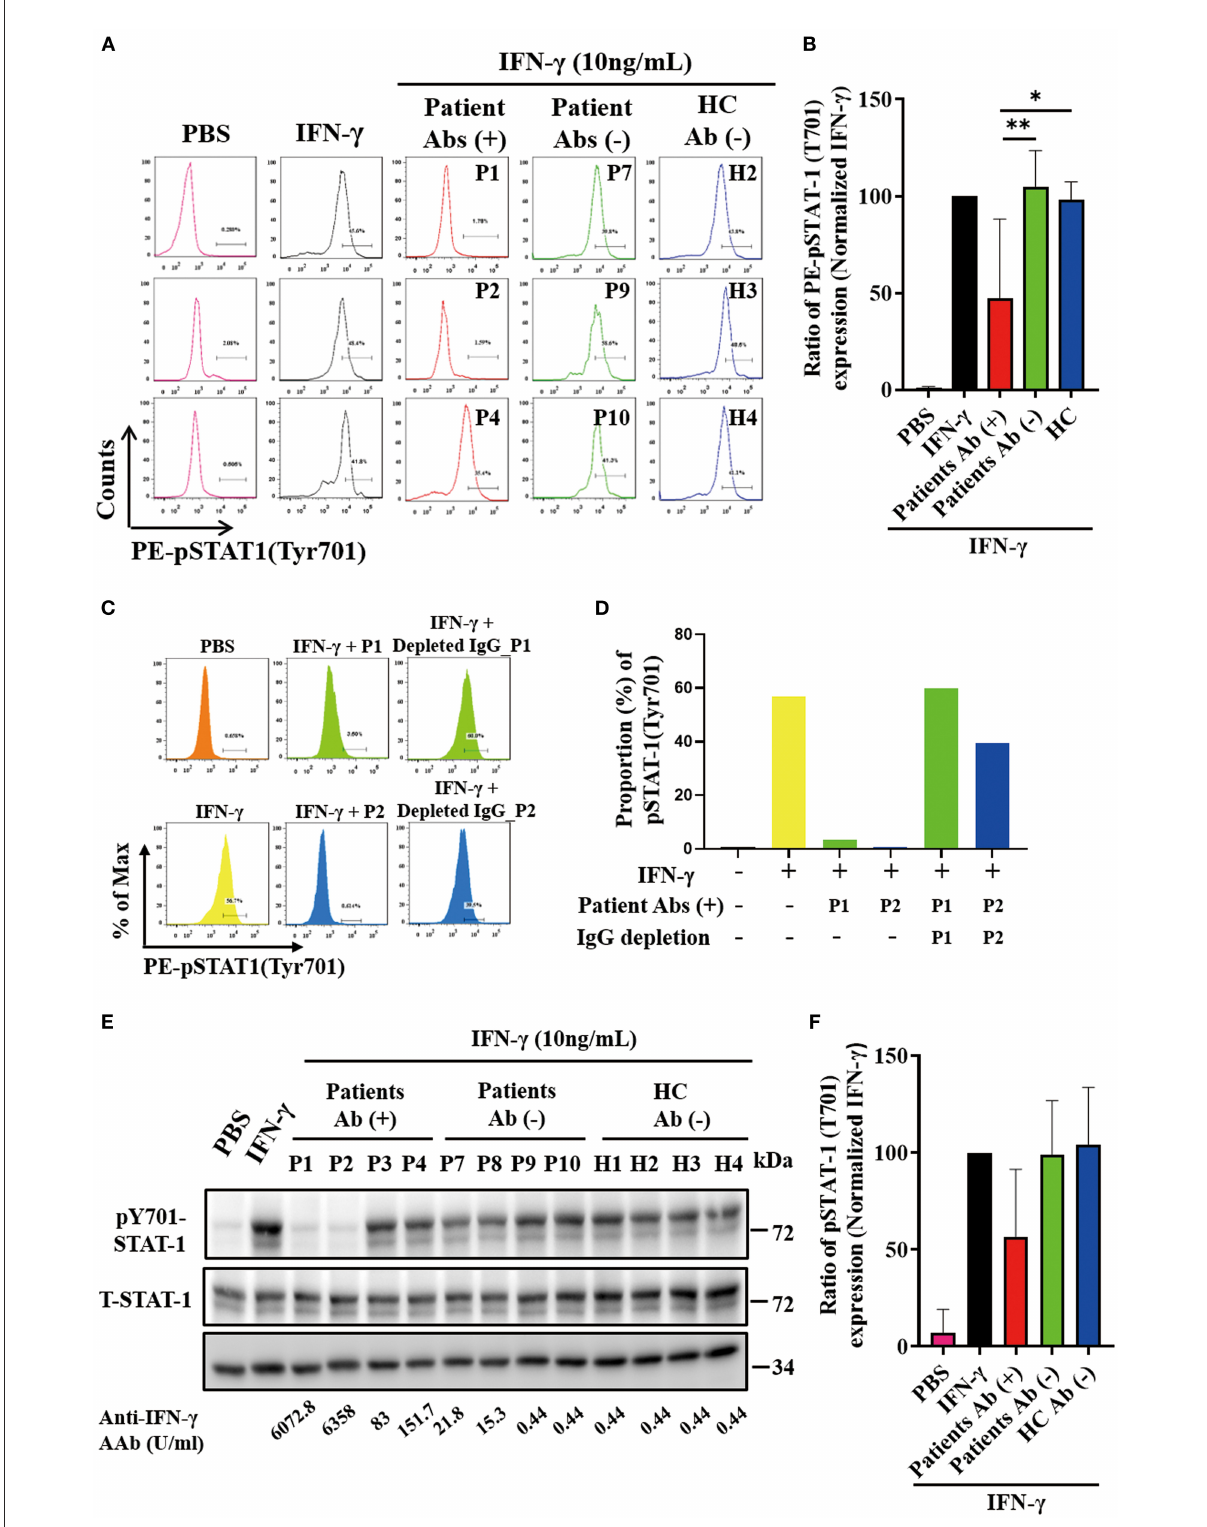
FIGURE2 Effective neutralization of IFN- γ signaling by anti-IFN- γ autoAbs. (A) The representative histograms of the inhibitory effects on the IFN- γ -induced PE (phycoerythrin)-STAT1 phosphorylation in THP-1 cells treated with serum samples from autoAbs-positive AOSD patients (P1, P2, and